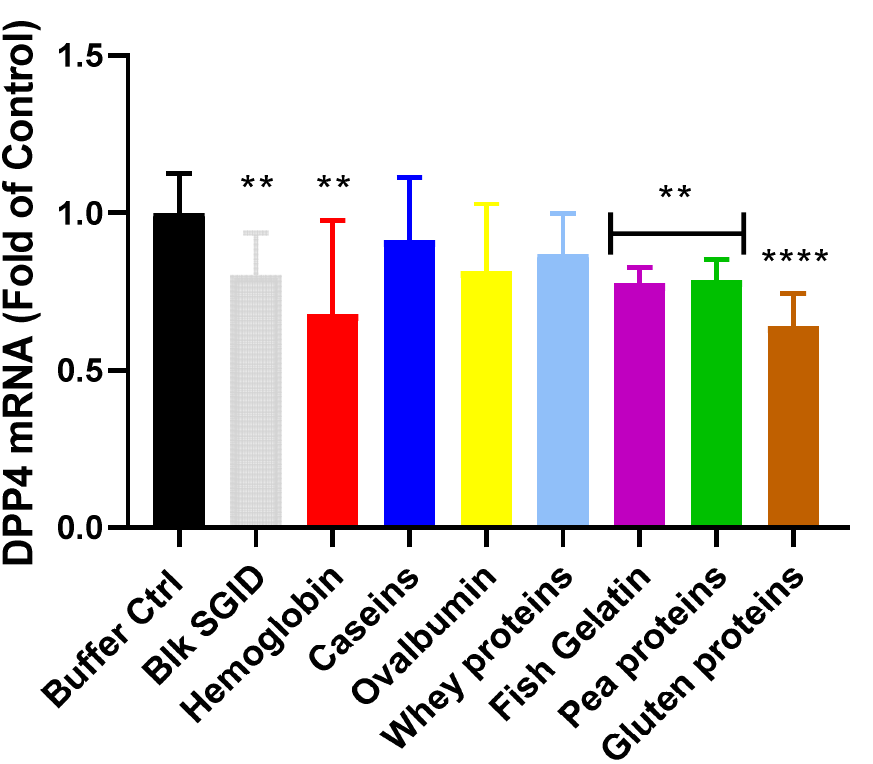
Figure 4. Digested proteins inhibit DPP-IV gene expression after 24 h in a Caco-2/HT29-MTX coculture. The digested protein samples (5 mg · mL − 1 ) were incubated with Caco-2/HT29-MTX cocultured cells for 24 h before DPP-IV gene expression measurement by qPCR normalized to HPRT1. The values are the means of nine repeated measurements (N = 3 in triplicate). The statistical analysis was performed using Kruskal–Wallis analysis with Dunn’s post-hoc test (** p < 0.01; **** p < 0.0001).